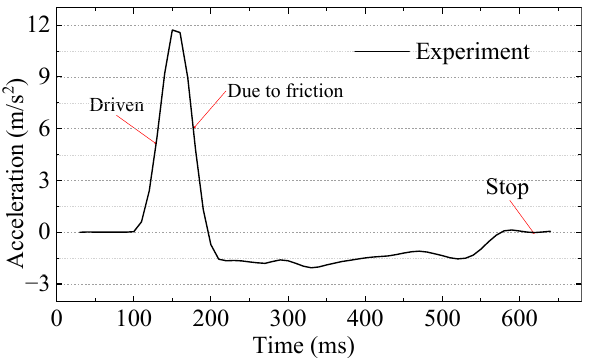
Figure 25. Acceleration of the mover versus time.